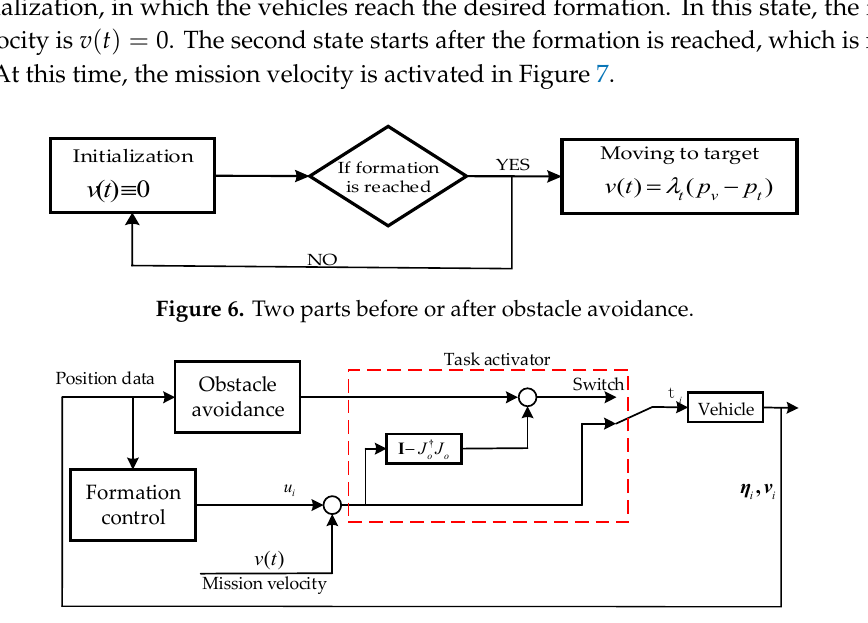
Figure 7. Control scheme for formation with obstacle avoidance function.